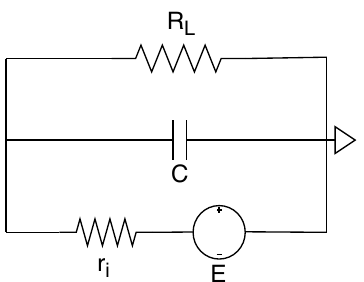
Figure 5. Electrical circuit model of a batteryless IoT